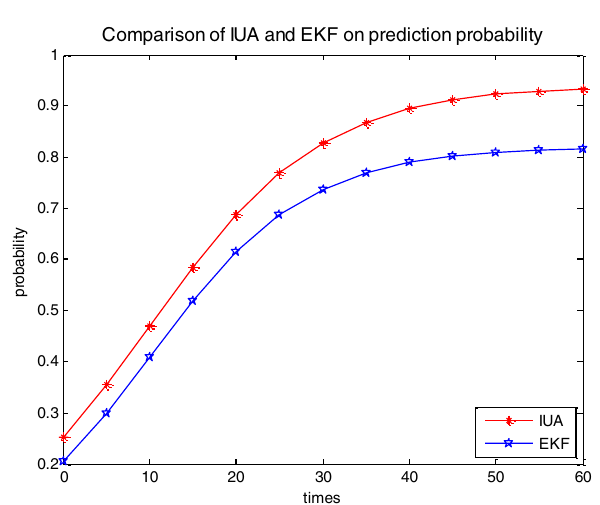
Figure 4. Comparison of IUA and EKF algorithms on prediction probability of traffic flow.